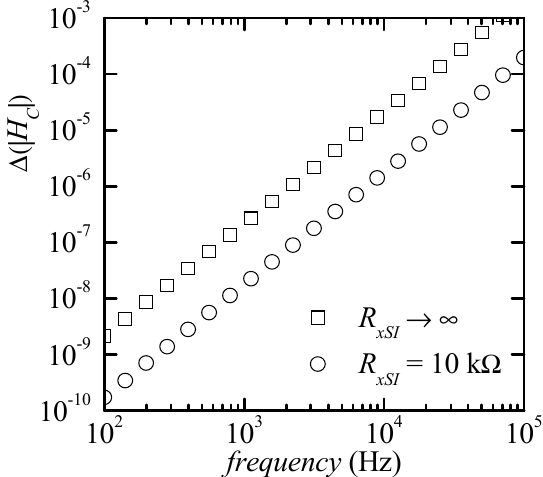
Figure 5. Maximum deviation of the modulus of the correction function H C vs. frequency. The empty squares refer to the same simulation condition in which Figure 4 has been obtained. In the case of the empty circles, the only change was the presence of 10 k Ω snap-in resistances in parallel to R I , R 2 and R R in Figure 1.